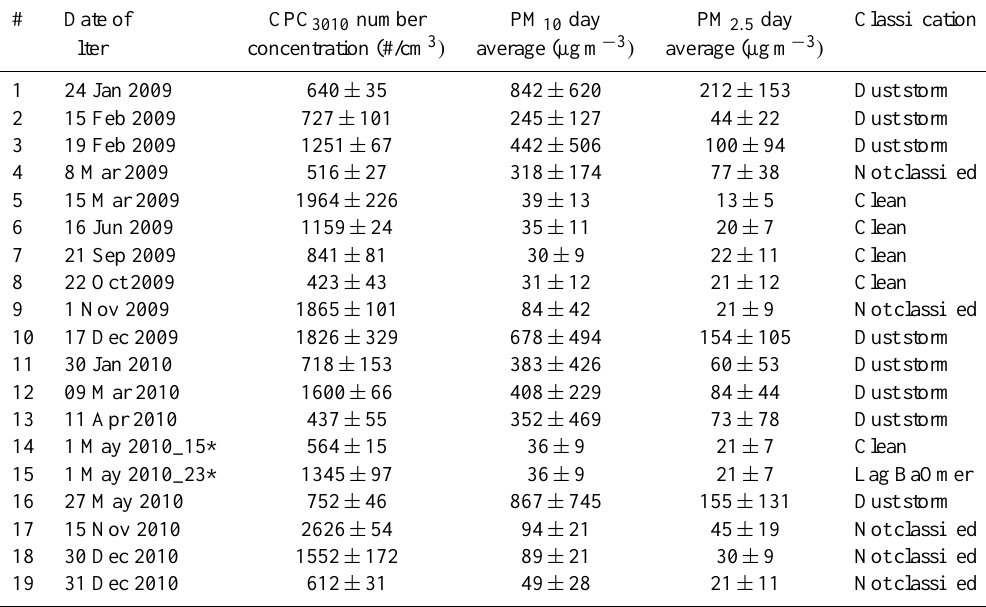
Table 1. List of filters sampled, total concentrations of particles and PM values with standard deviation. # Date of CPC 3010 number PM 10 day PM 2 . 5 day Classification filter concentration (#/cm 3 ) average (µgm − 3 ) average (µgm − 3